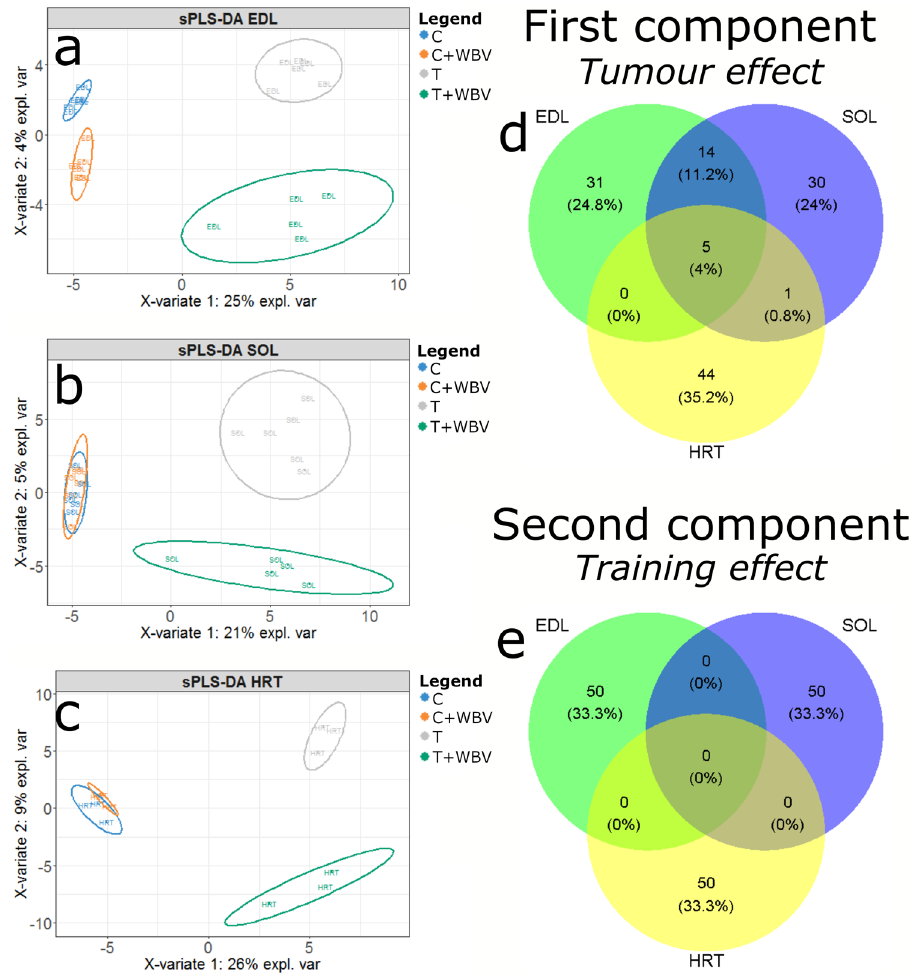
Figure 8. Microarray results showing a partial least squares discriminant analysis of all four groups with two components and 50 genes per component. sPLS-DA is performed per tissue, EDL ( a ), SOL ( b ) and heart [HRT] ( c ). Venn diagrams display genes per tissue in component 1 ( d ) and 2 ( e